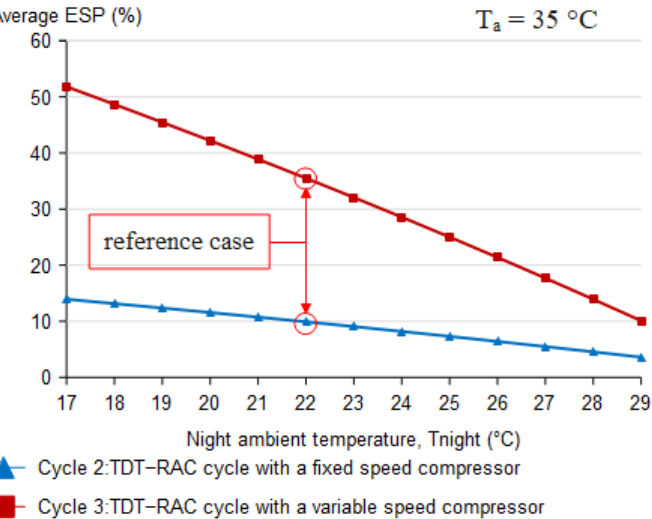
Figure 8. Average ESP versus night ambient temperature (the day time ambient temperature is set as 35 °C).